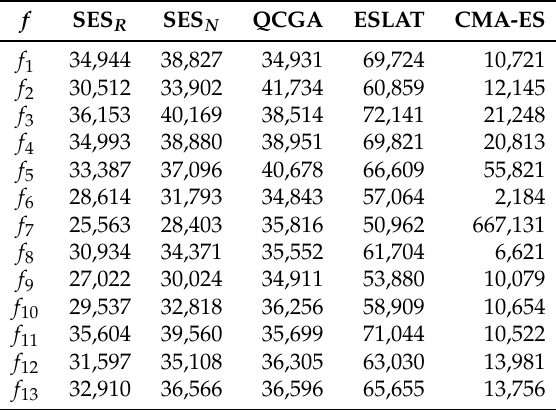
Table 5. Solutions costs (Numbers of function